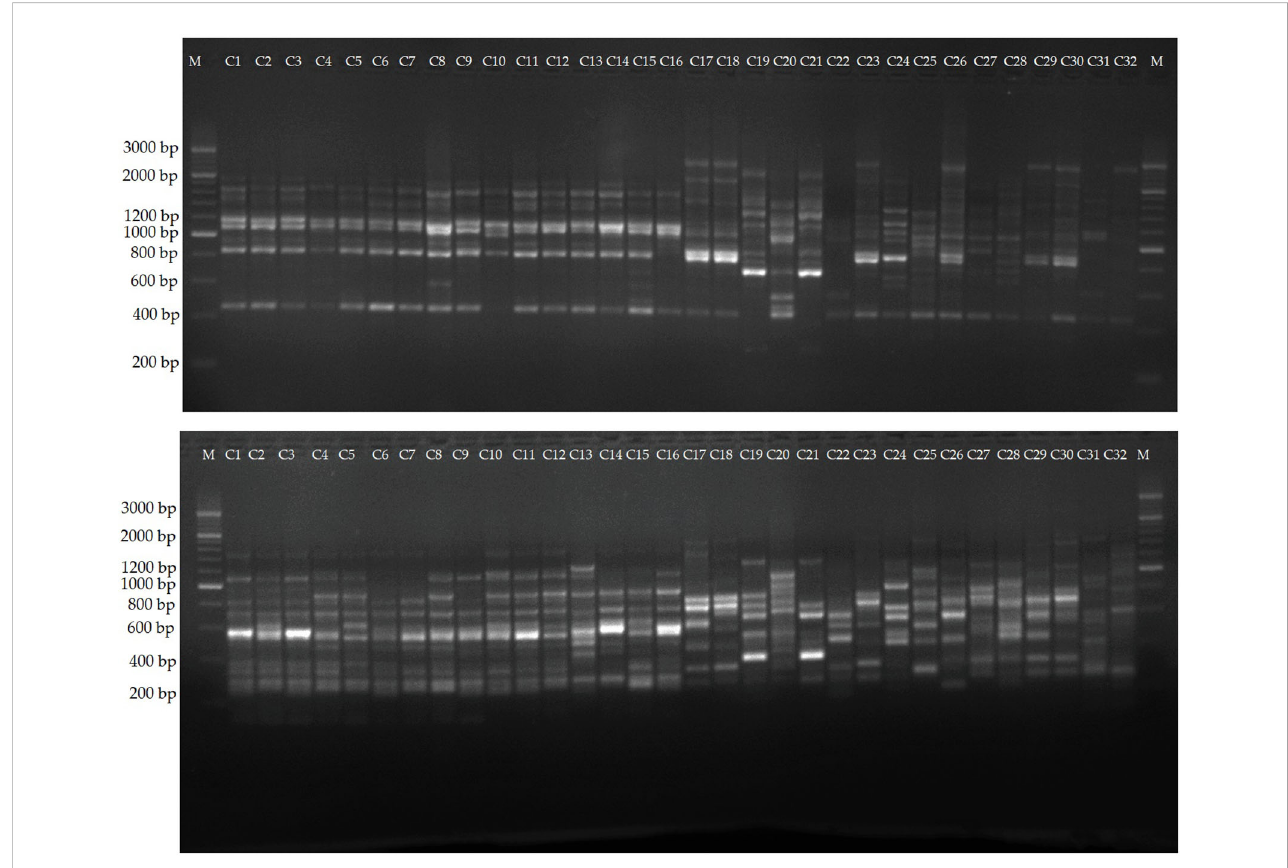
FIGURE 5 Ampli fi cation pro fi les of markers SCoT 6, and SCoT 13. Lane 1-16, different C. persicum genotypes, 16-32, different Cyclamen